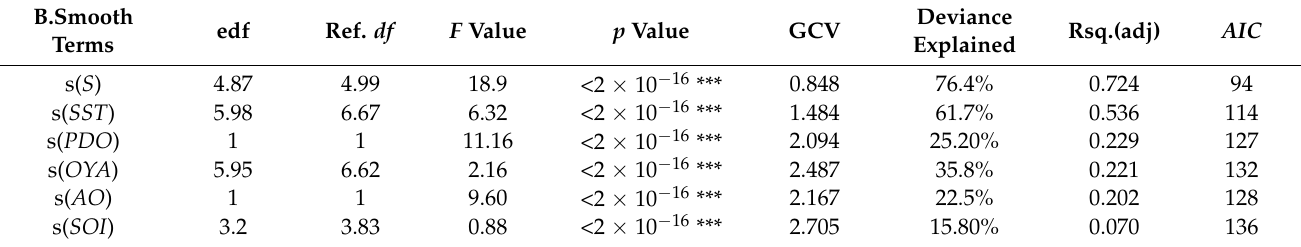
Table 4. Results of the GAM single factor fit of S. melanostictus